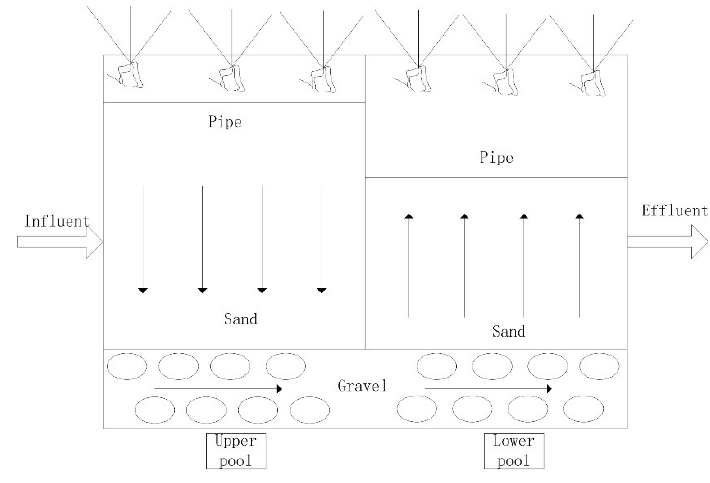
Figure 1. Schematic diagram of the constructed wetland (CW) in Zhoushan, China.